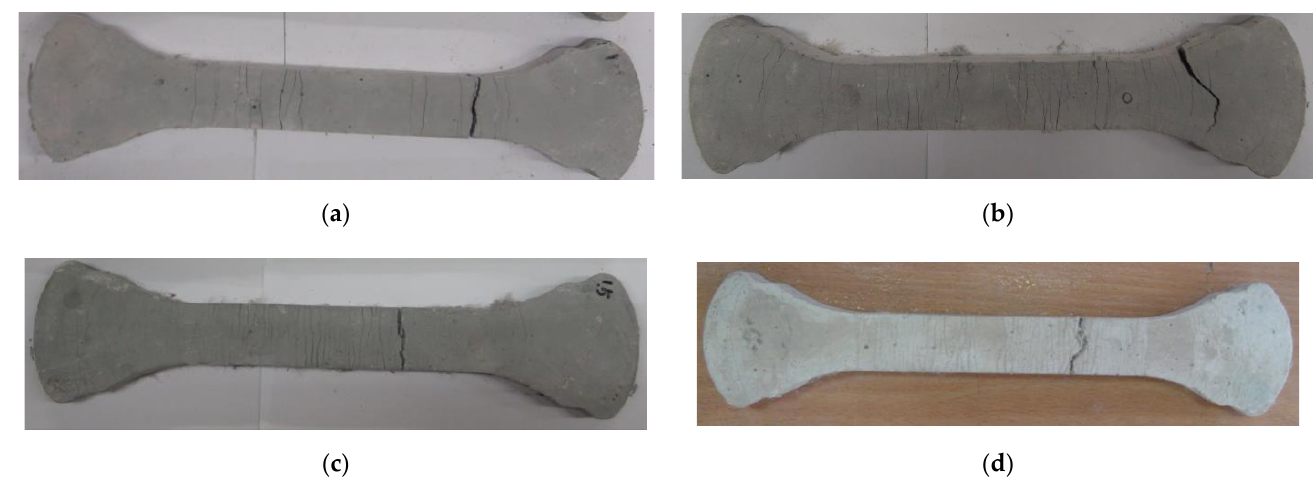
Figure 8. Multiple microcracks of tensile specimens: ( a ) ASFC100 (PVA 1.00 vol.%); ( b ) ASFC125 (PVA 1.25 vol.%); ( c ) ASFC150 (PVA 1.50 vol.%); ( d ) ASFC200 (PVA 2.00 vol.%). Table 6. Direct uniaxial tensile test results.